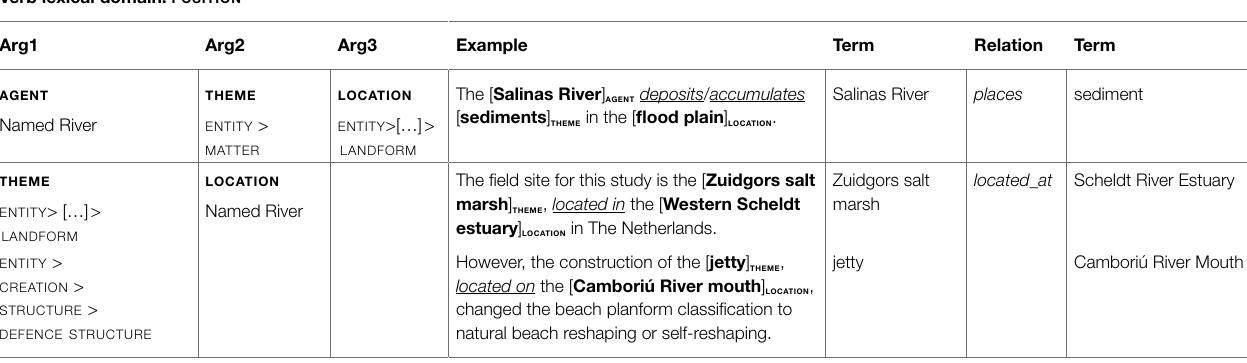
TABLE 9 | Results from the semantic annotations for the lexical domain of position . Verb lexical domain: position Arg1